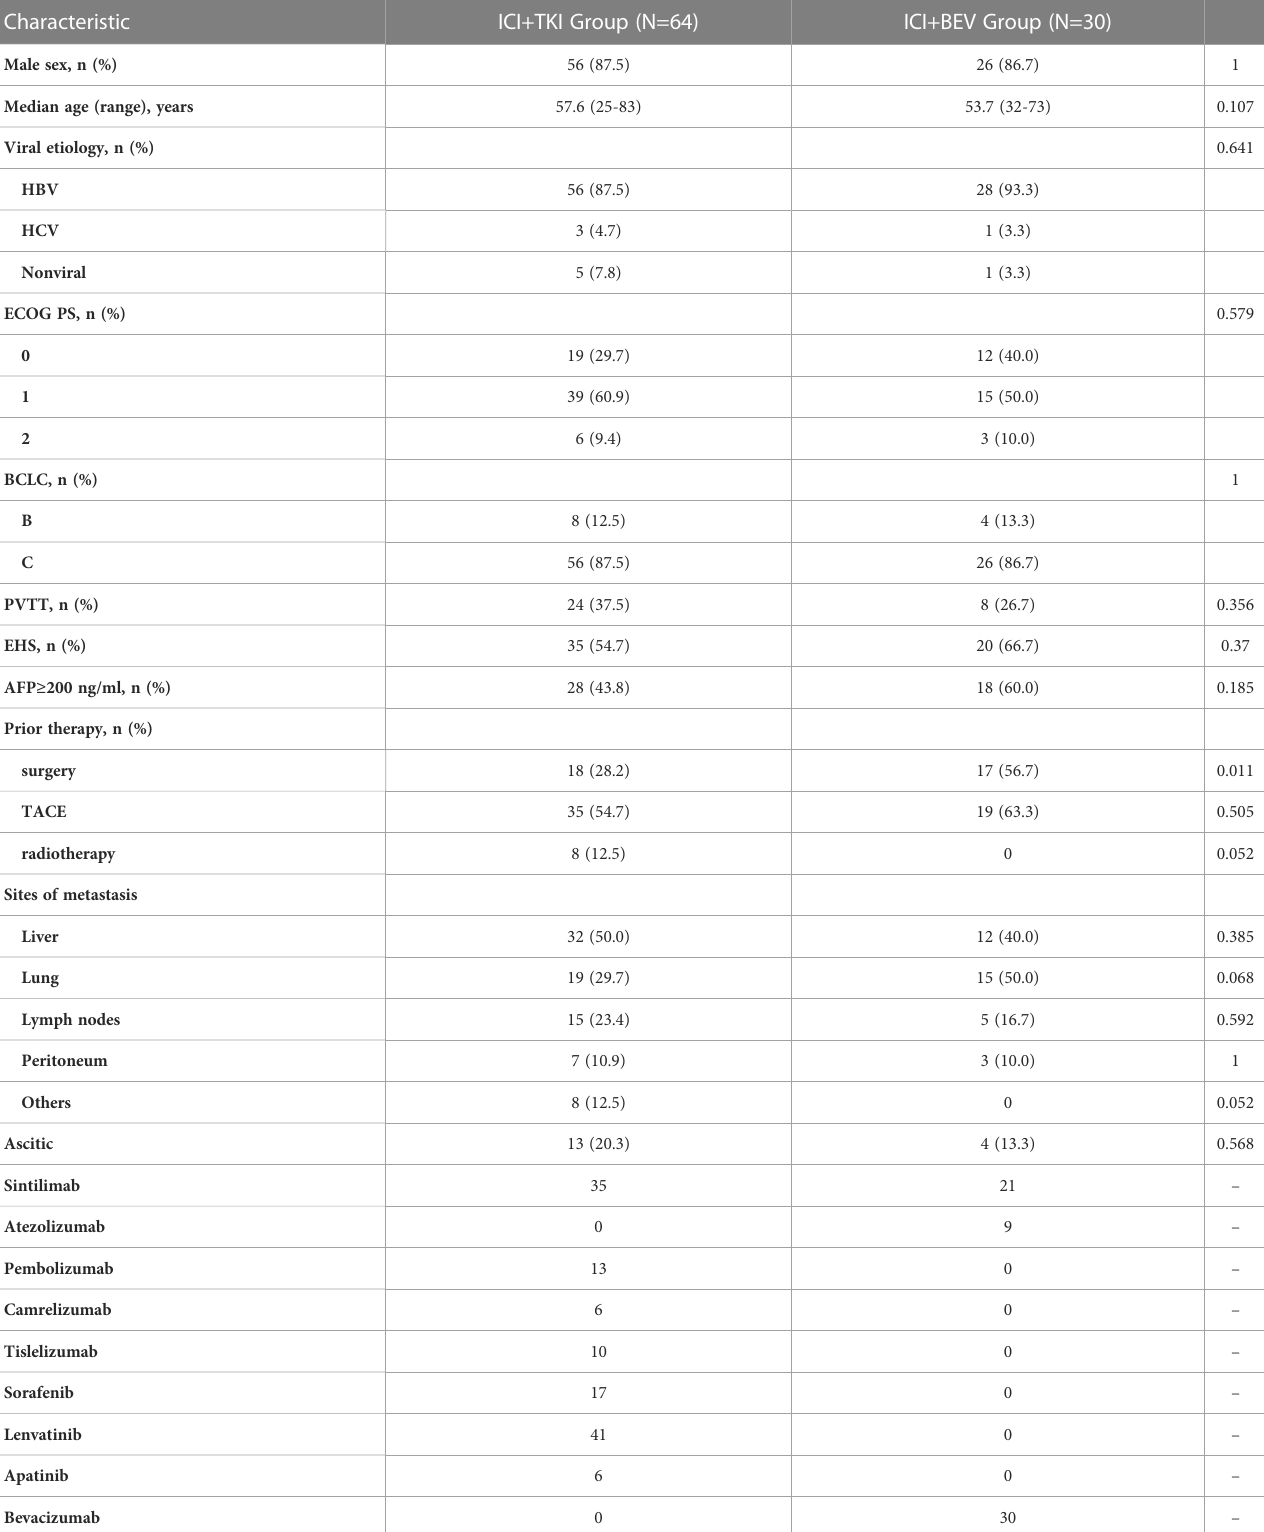
TABLE 1 Baseline Characteristics of the Study